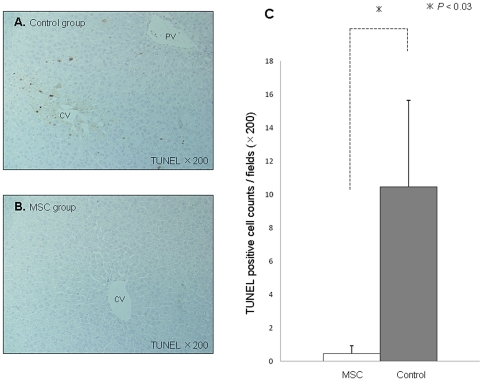
Minimal TUNEL-positive hepatocytes by BM-MSC transplantation.TUNEL staining of I/R-injured liver sections from the MSC group (A. upper panel) and the Control group (B. lower panel). C. Quantification of TUNEL-positive hepatocyte nuclei was assessed by calculating the mean of the number of TUNEL-positive hepatocytes in 10 random high-power fields per animal. Abbreviations: CV, central vein; PV, portal vein.